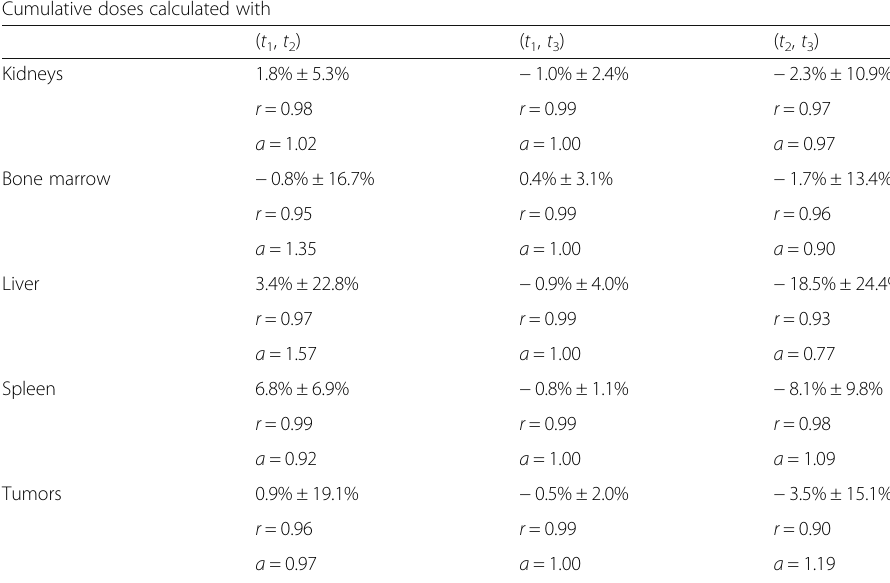
Table 2 Angular coefficients a , Pearson ’ s coefficients r , and mean relative errors in cumulative doses from the standard calculation obtained for the kidneys, bone marrow, liver, spleen, and tumors when calculated using the three different “ 2 time-points protocols ” Cumulative doses calculated